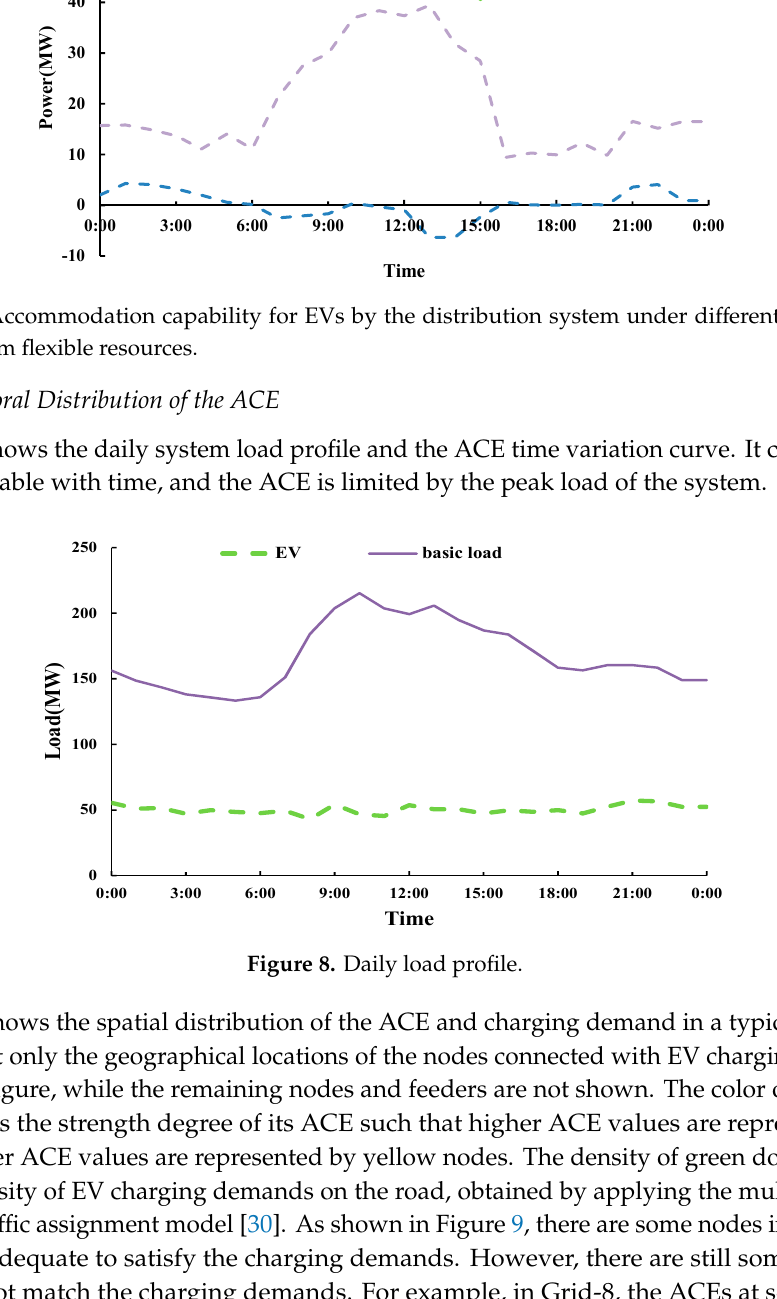
Figure 7. Accommodation capability for EVs by the distribution system under different cases and outputs from flexible resources.